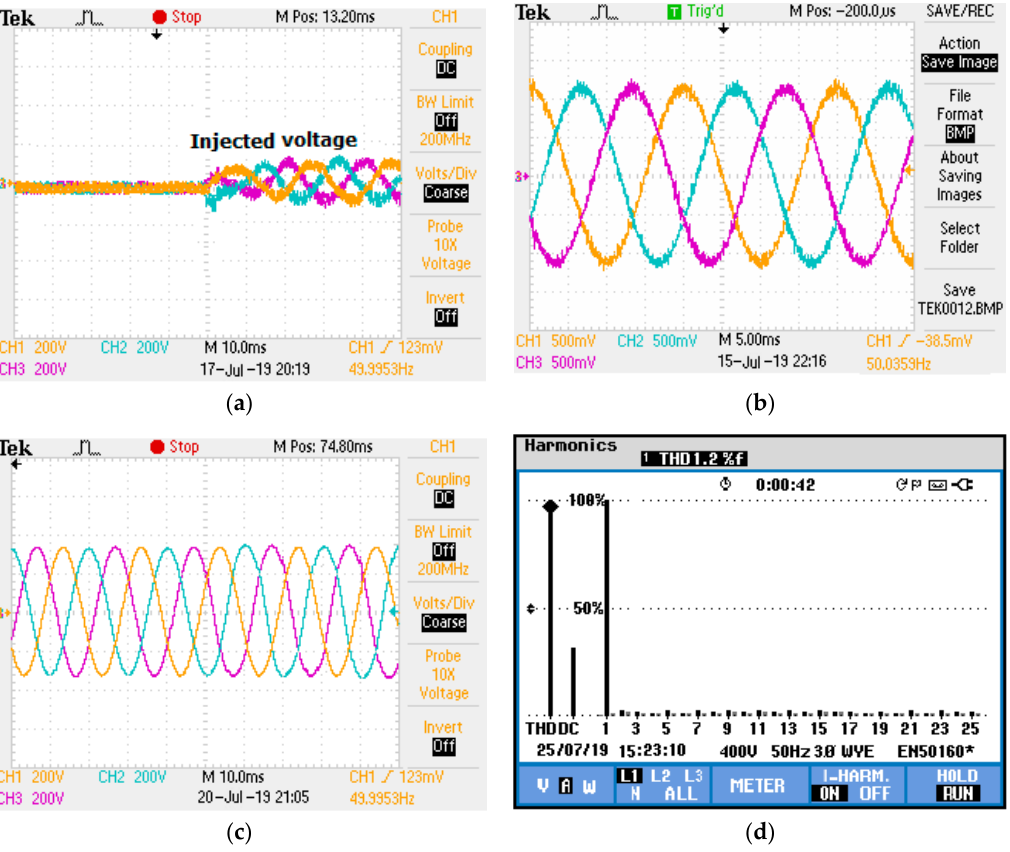
Figure 20. Experimental results under balanced voltages with unbalanced loads: (a) injected voltage; (b) compensated source current; (c) load voltage; and (d) THD level of source current after connecting solar photovoltaic-supported QZSI-unified power quality conditioner in a phase-A.